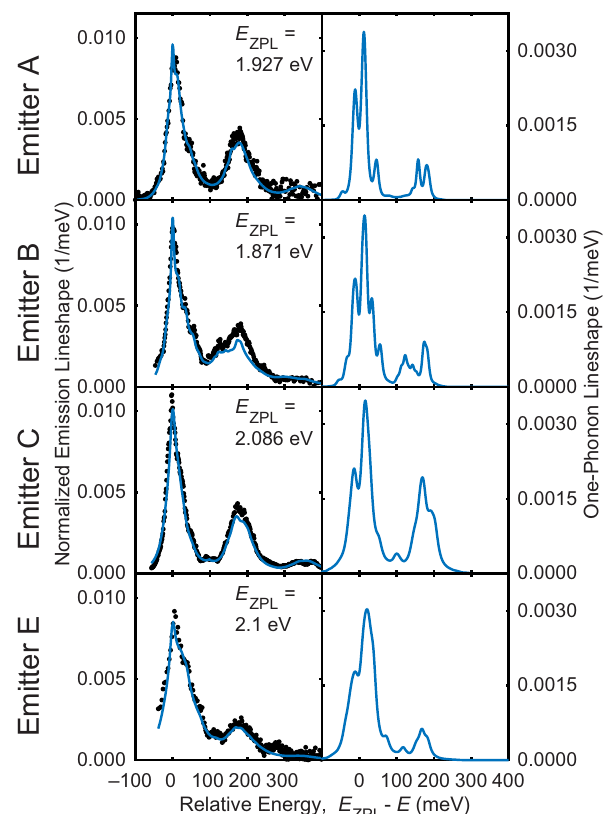
FIG. 2. PL emission lineshapes. Left column: observed spec- tral emission lineshapes (black points) and fits according to Huang-Rhys theory (blue curve). Experimental uncertainties are comparable to the size of the data points. Right column: one- phonon vibronic coupling lineshape corresponding to the fits in the left